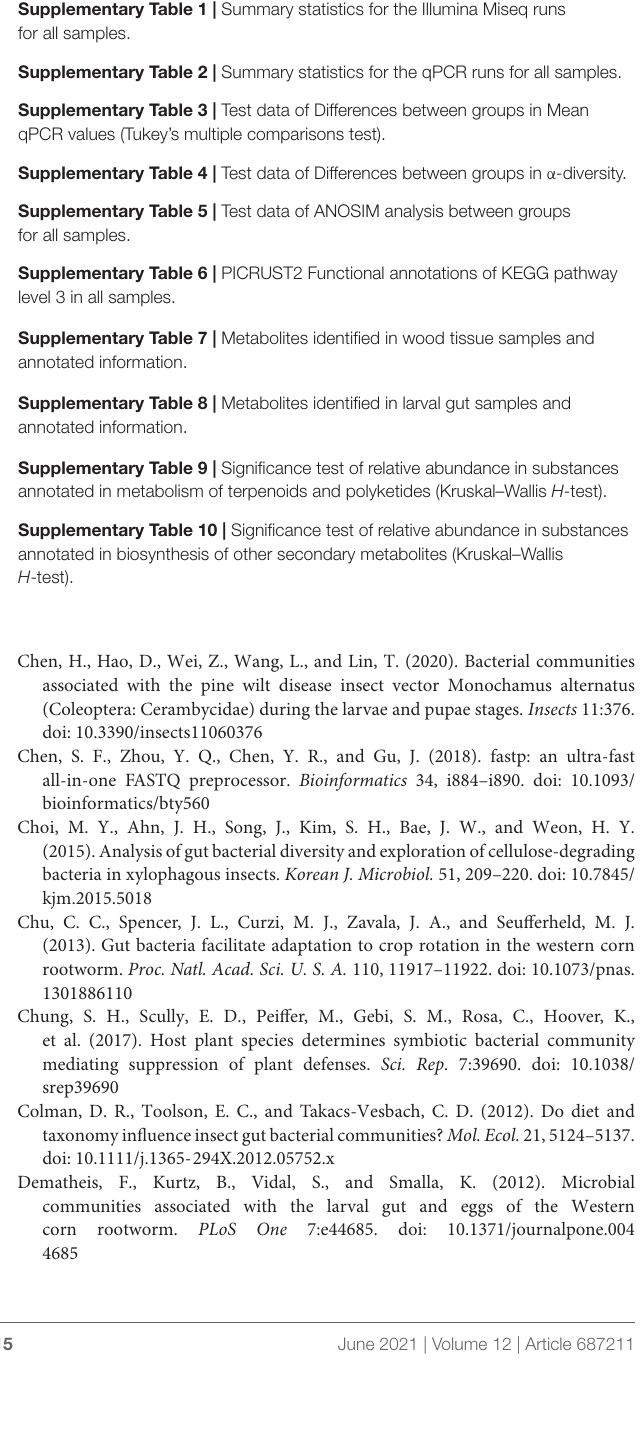
Supplementary Figure 1 | Rarefaction curves of bacterial communities in the intestine samples of Monochamus saltuarius fed on different host tree species. Sobs: number of species observed in the sample; PK: mid-guts of P. koraiensis fed larvae; PT: mid-guts of P. tabuliformis fed larvae; PS: mid-guts of P. sylvestris fed larvae.